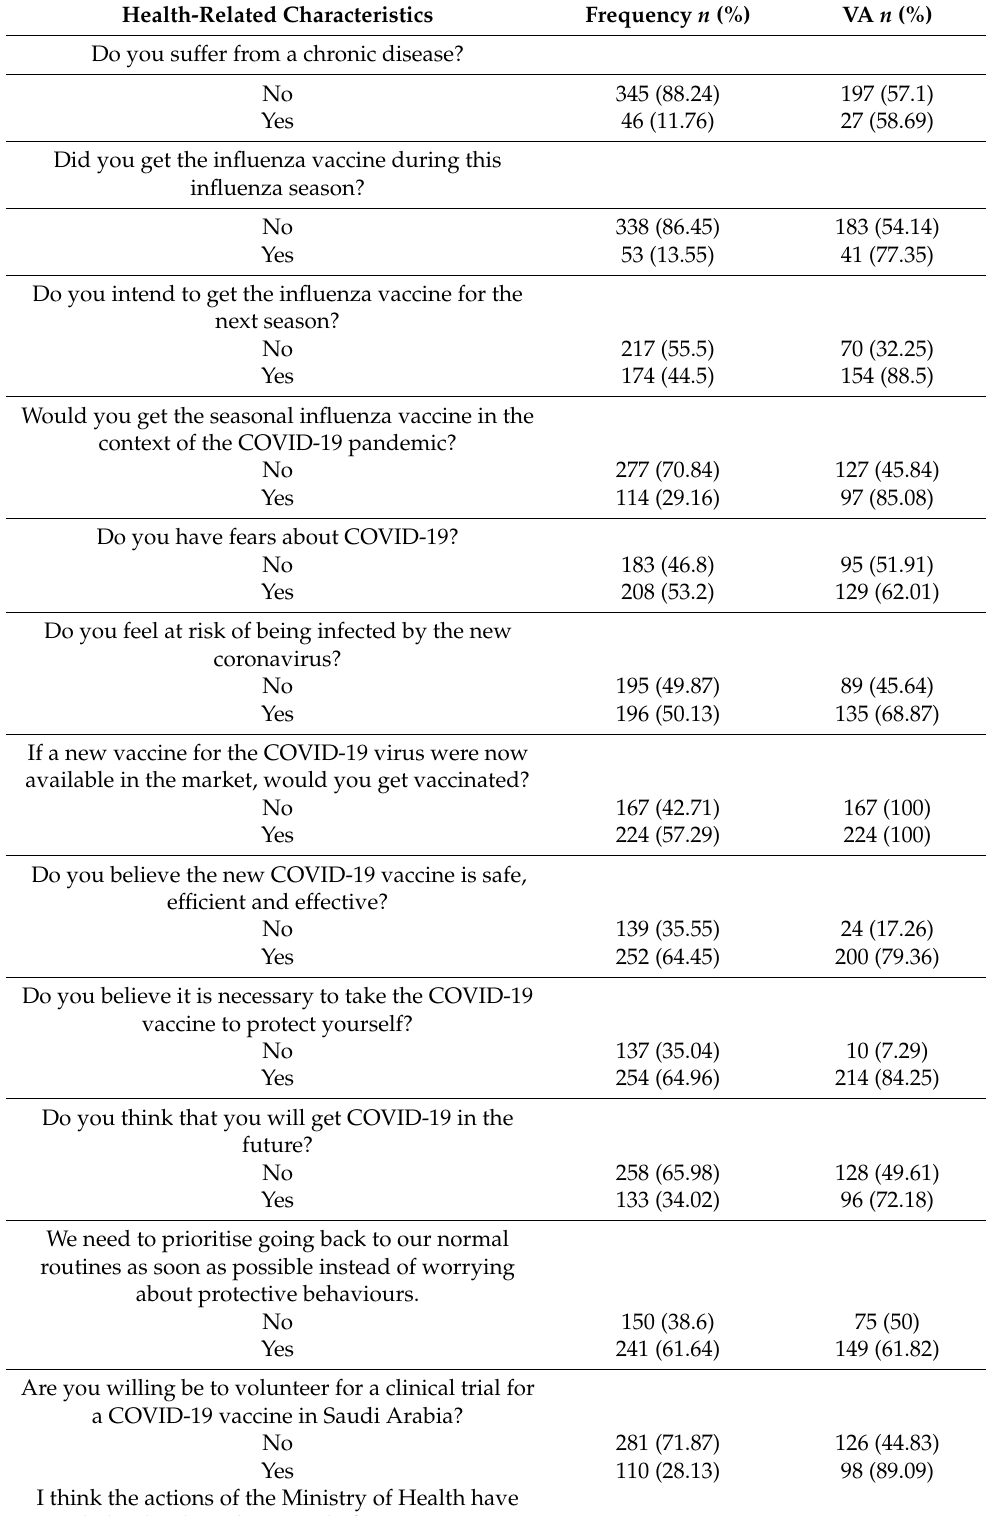
Table 2. Health and COVID-19 vaccine-related characteristics of participants ( n = 391). Health-Related